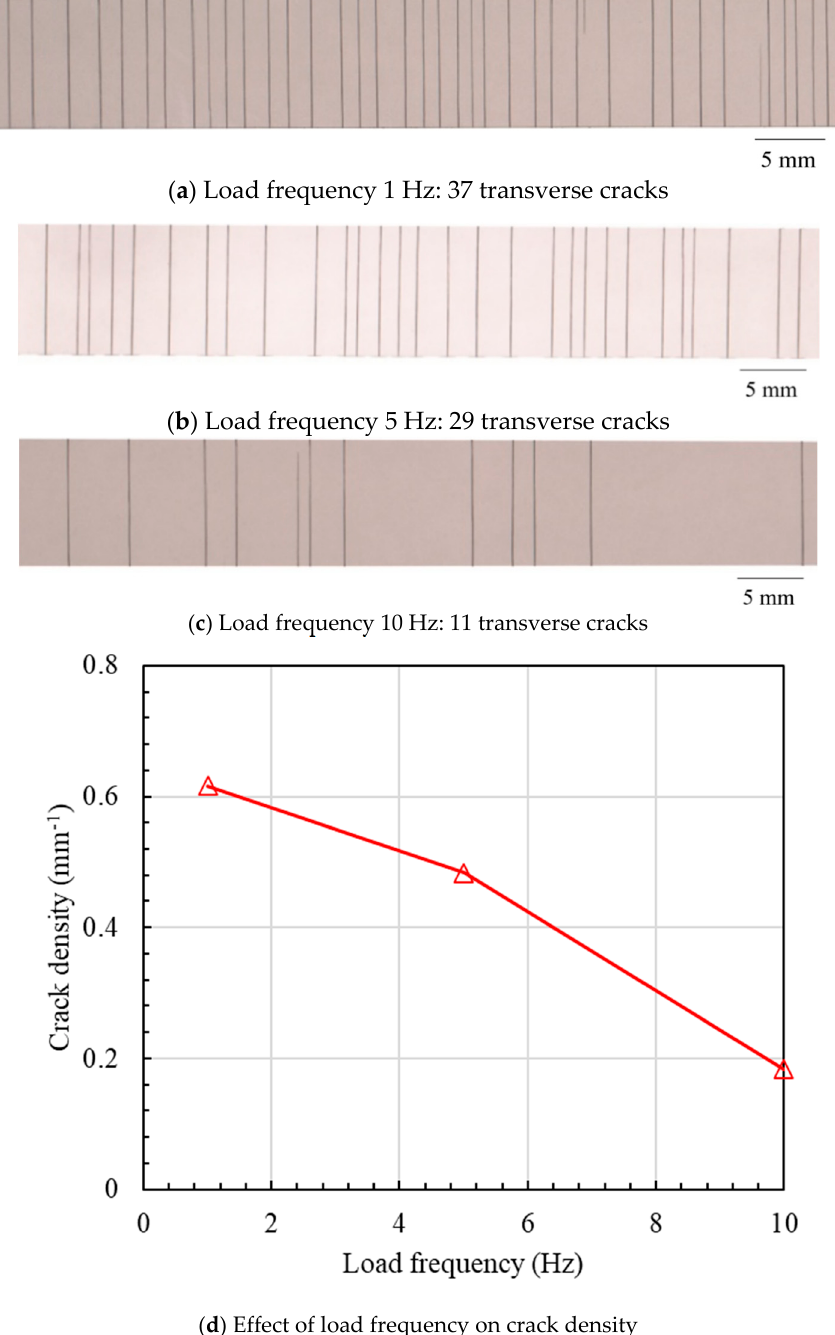
Figure 6. Transverse crack distribution under various load frequencies (10 5 cycles).